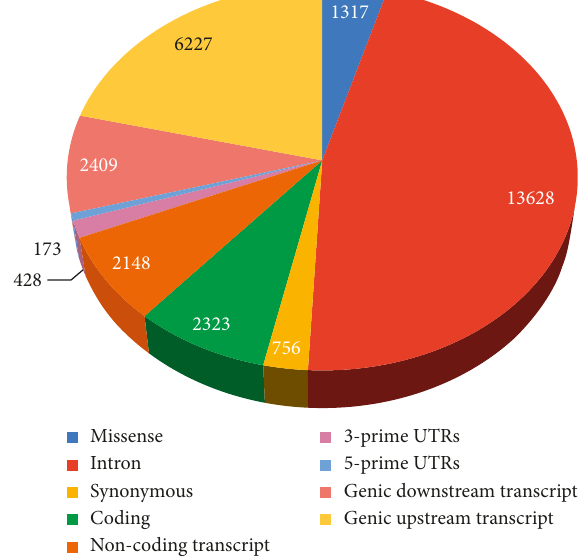
Figure 2: Mutation type of POLD1.